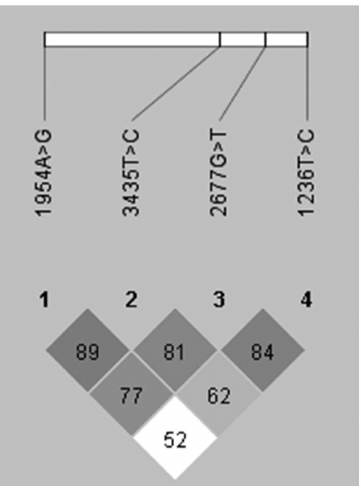
Figure 2. Linkage disequilibrium (LD) plot of ABCB1 (1236T . C, 2677G . T, 3435T . C) and ABCB4 (1954A . G) polymorphisms. Each square represents a pairwise LD relationship formed between the two single polymorphisms with D’ values multiplied by 100 shown inside the squares. The shade of grey indicates the degree of LD significance. Dark grey squares represent statistically significant LD as measured by D’ up to a maximum of 1. White squares indicate D’ values less than 1 with no statistically significant